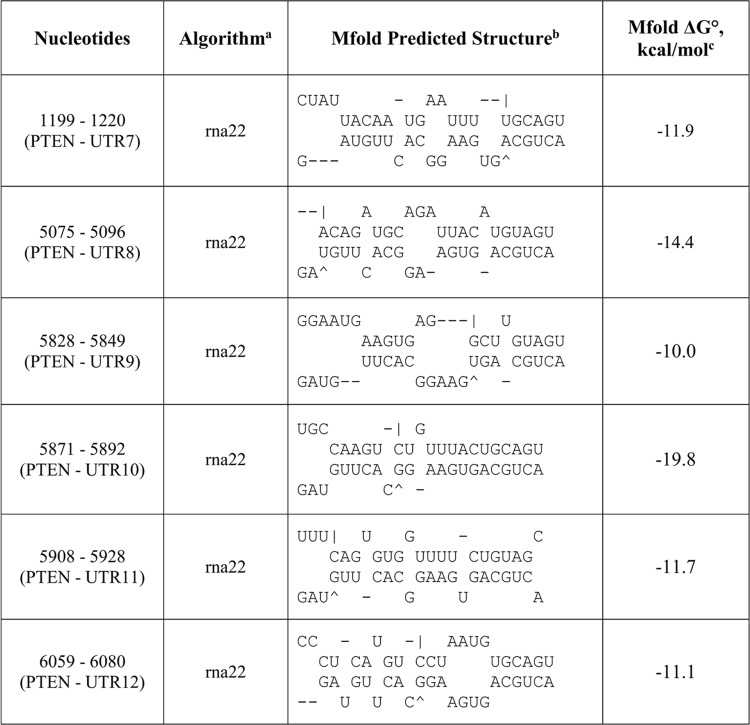
Predicted miR-17-3p passenger strand binding sites in the 3'UTR of PTEN mRNA.
aThe potential oncomiR:mRNA binding sites were identified by rna22, Targetscan, or miRanda. bTop strand is mRNA (5' ➔ 3') and the bottom strand is oncomiR (3' ➔ 5'). cCalculated at http://mfold.rna.albany.edu/?q=mfold.